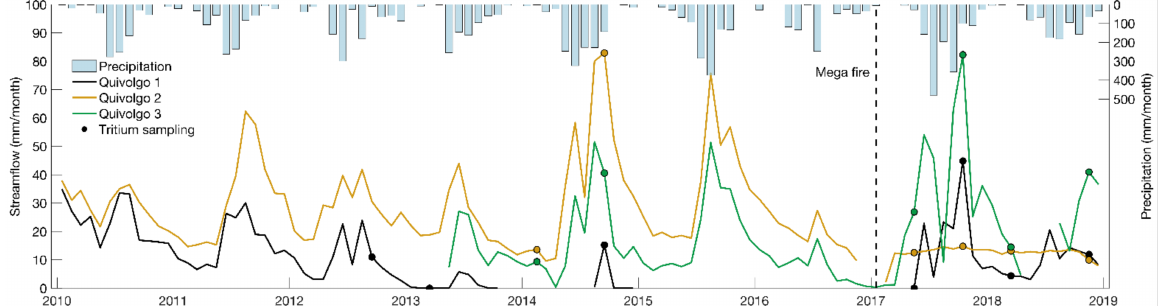
Figure 3. A time course of monthly streamflow (in mm) for the three study catchments between 2010 and 2018. The dates of water sampling for tritium analysis are indicated by colored dots.